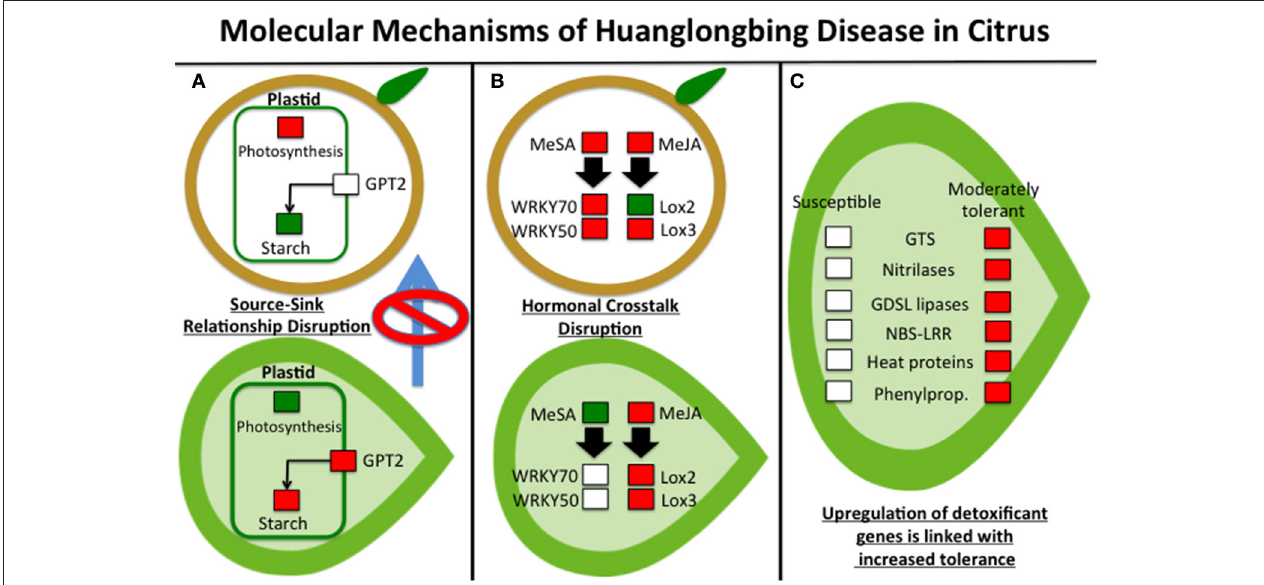
FIGURE 1 | The three main molecular mechanisms driving symptom progression of Huanglongbing disease in citrus: (A) source-sink disruption due to starch accumulation in leaves, stimulated by upregulation of glucose-phosphate-transport2 (GPT) and the induction of genes involved in photosynthetic reactions in fruits; (B) non-beneficial modulation of jasmonic acid-salicylic crosstalk that is not correlated with the different pathogen concentration in leaf and fruit tissues; and (C) modulated expression of detoxifying proteins linked with different susceptibility of citrus genotypes. Red color means “upregulated,” green means “downregulated” while white means “not-regulated.” Genes not mentioned in the text were: NBS-LRR (nucleotide binding site leucine rich repeats), lox2, and lox3 (lipoxygenase2 and 3), GTS (glutathione-S-transferases).